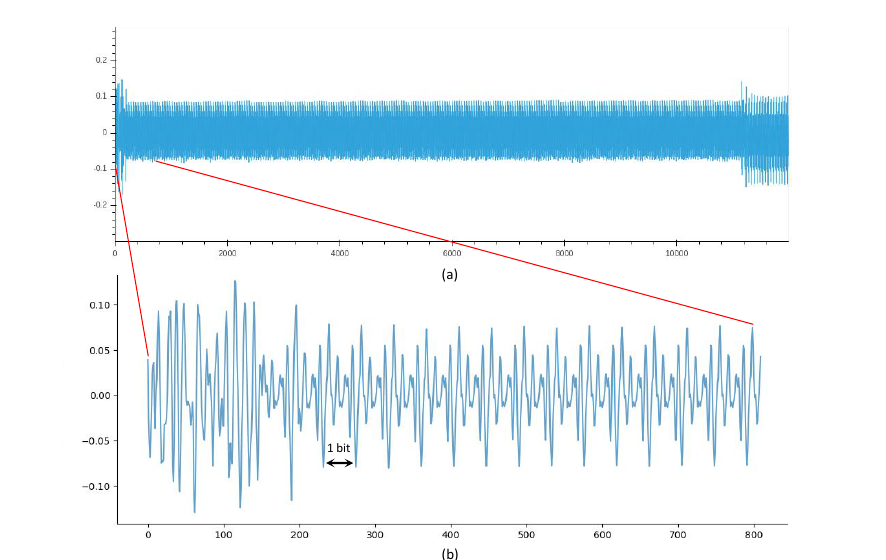
Figure 6: (a) The complete procedure poly_A2A() ; (b) The first 15 bits of poly_A2A()